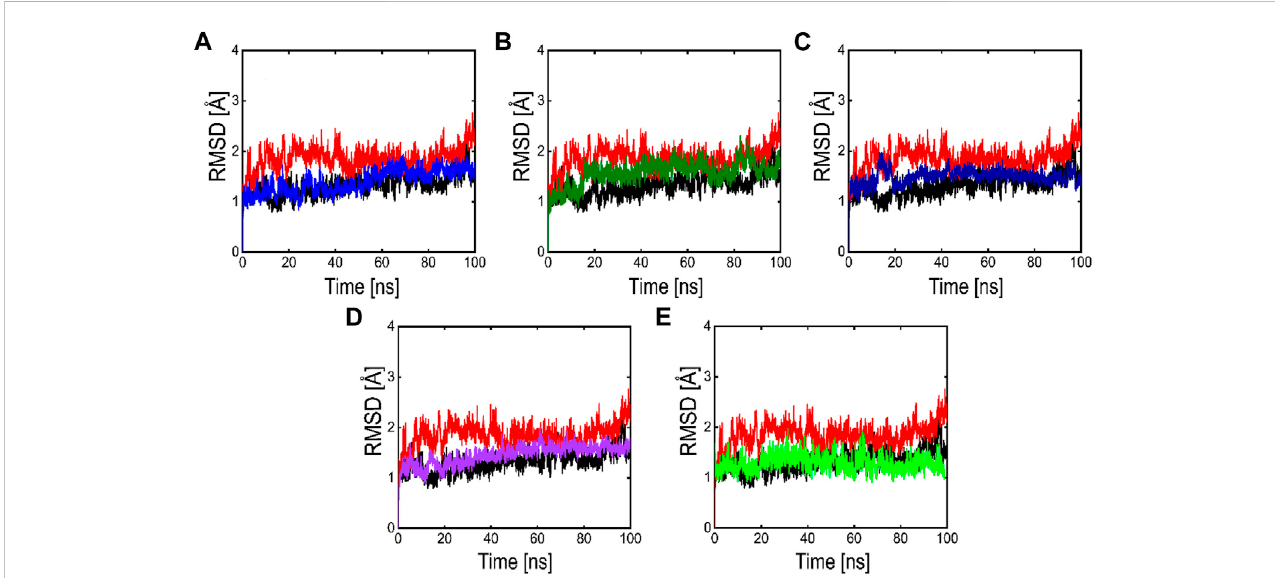
FIGURE 8 RMSD plots of the APO form (Black color), reference complex (Red color) and the top active phytochemicals (A) Compound 1 (B) Compound 2 (C) Compound 3 (D) Compound 4 and (E) Compound 5 bound to 3CL PRO .